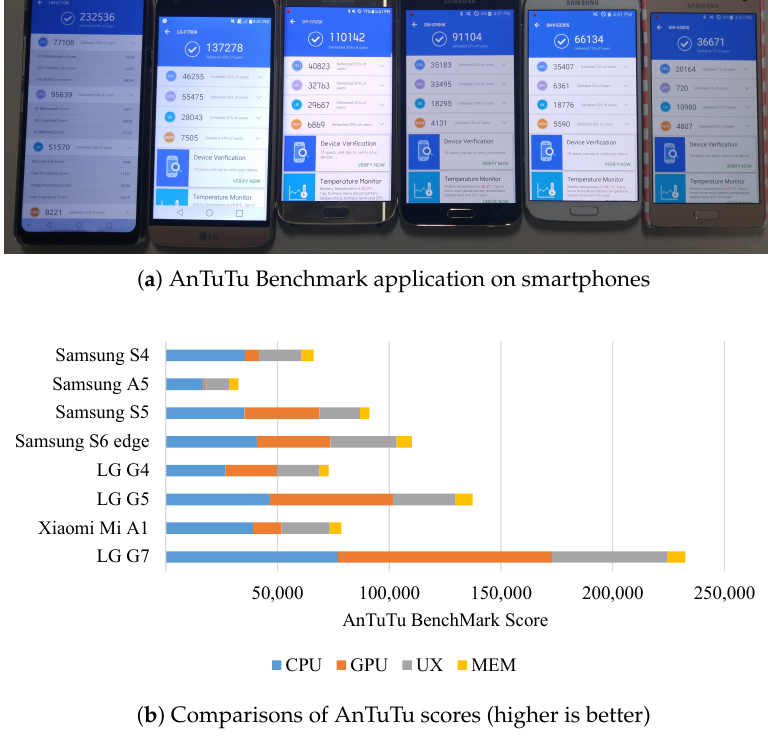
Figure 10. AnTuTu benchmark scores on Android